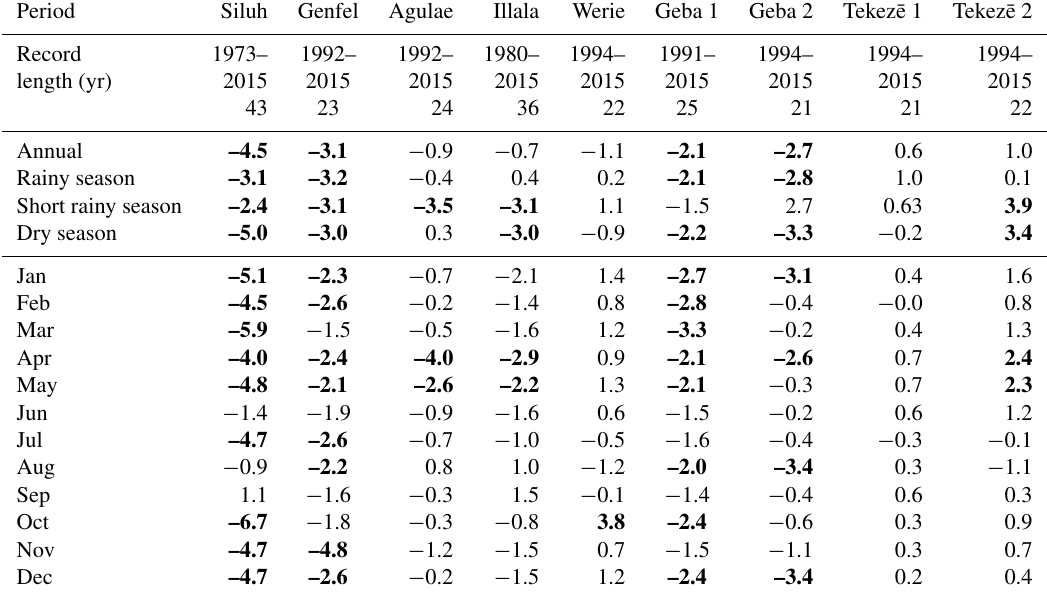
Table 5. Summary results of MK and Z statistics on streamflow trends. Negative (positive) Z value indicates a decreasing (increasing) trend and statistically significant trends at 5% confidence level are shown in bold ( Z =±